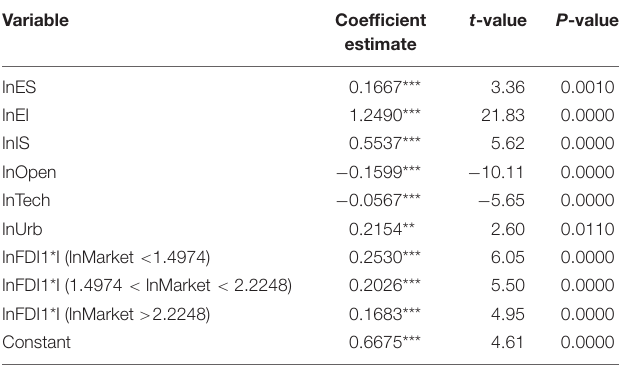
TABLE 4 | Regression results of double threshold effect.